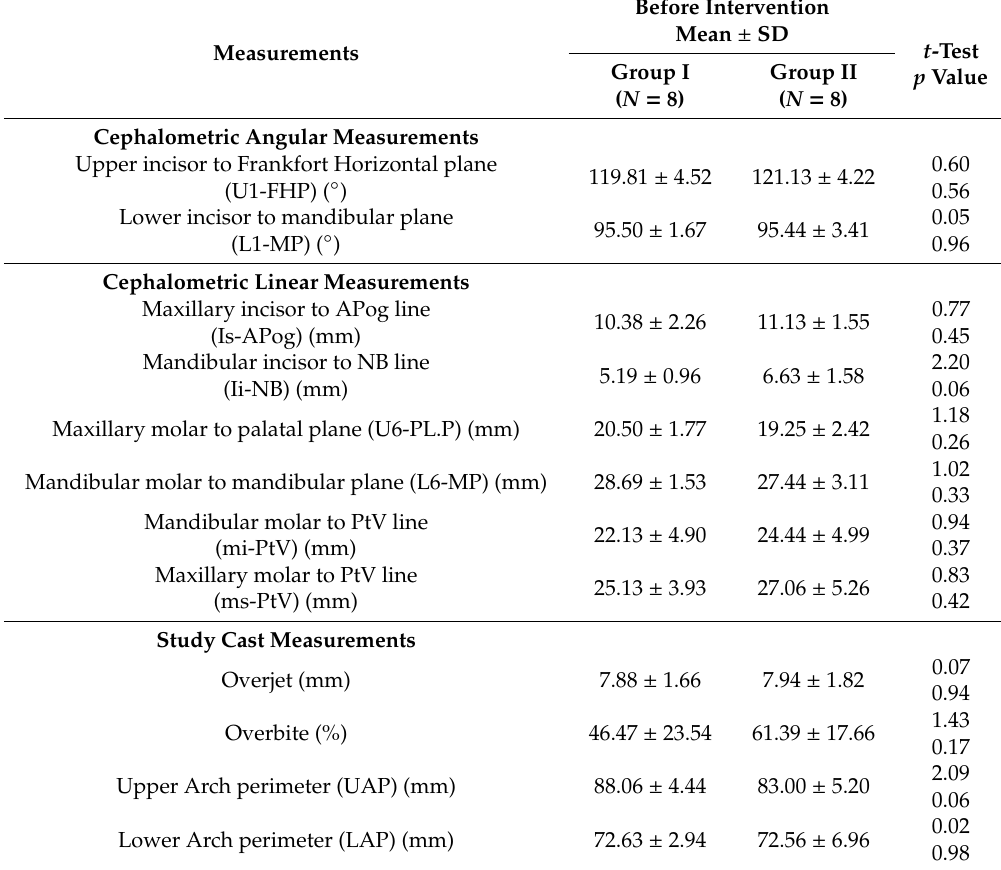
Table 1. Mean dentoalveolar angular (degrees) and linear measurements before intervention in Group I and Group